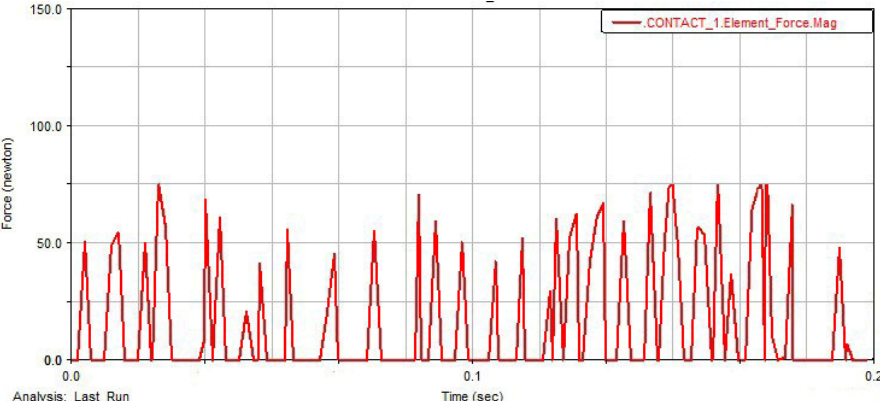
Figure 14. Comparison of friction between slider and rotor slider slot after stator optimization.